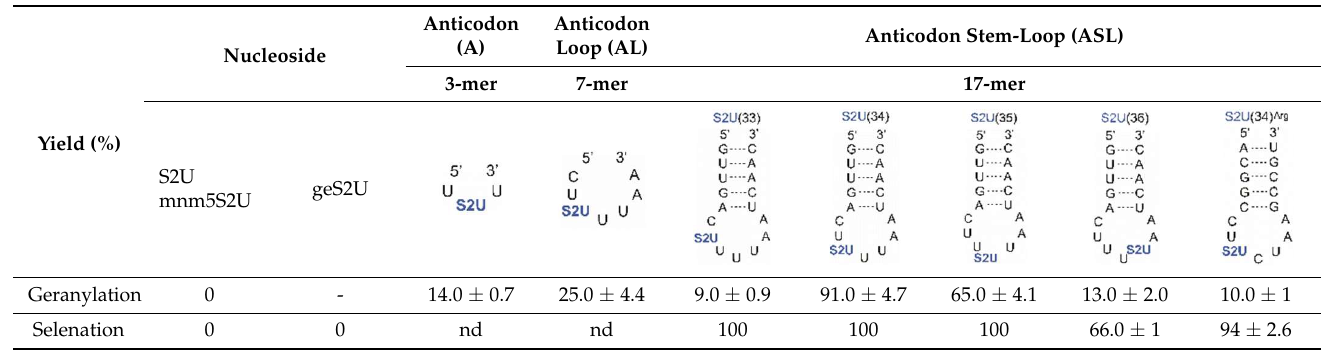
Table 1. MBP–SelU efficiency in geranylation and selenation reactions, dependence on the position of S2U in the RNA chain and the length of the RNA chain, nd—not determined.